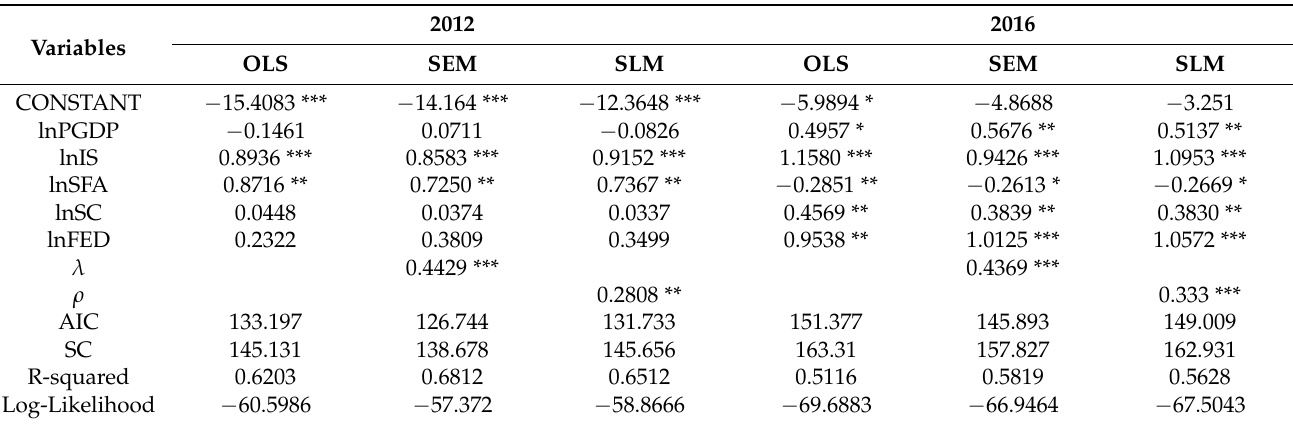
Table 3. Parameter estimation results of econometric models in the Guangxi